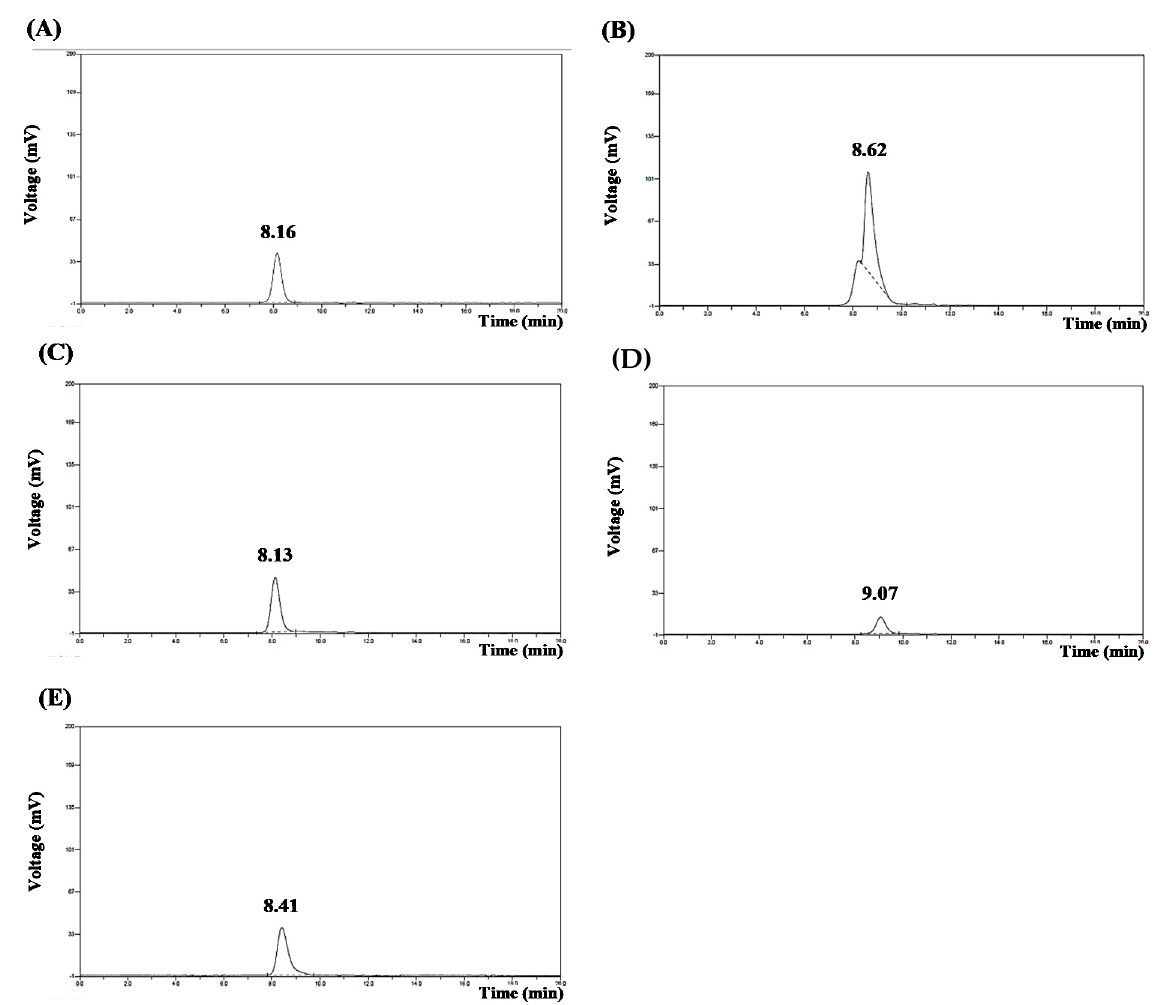
Figure 4. HPLC chromatogram of ( A ) R-PE standard, ( B ) C-PC standard, ( C ) R-PE fraction, ( D ) R-PC fraction and ( E ) small molecular PE fraction.